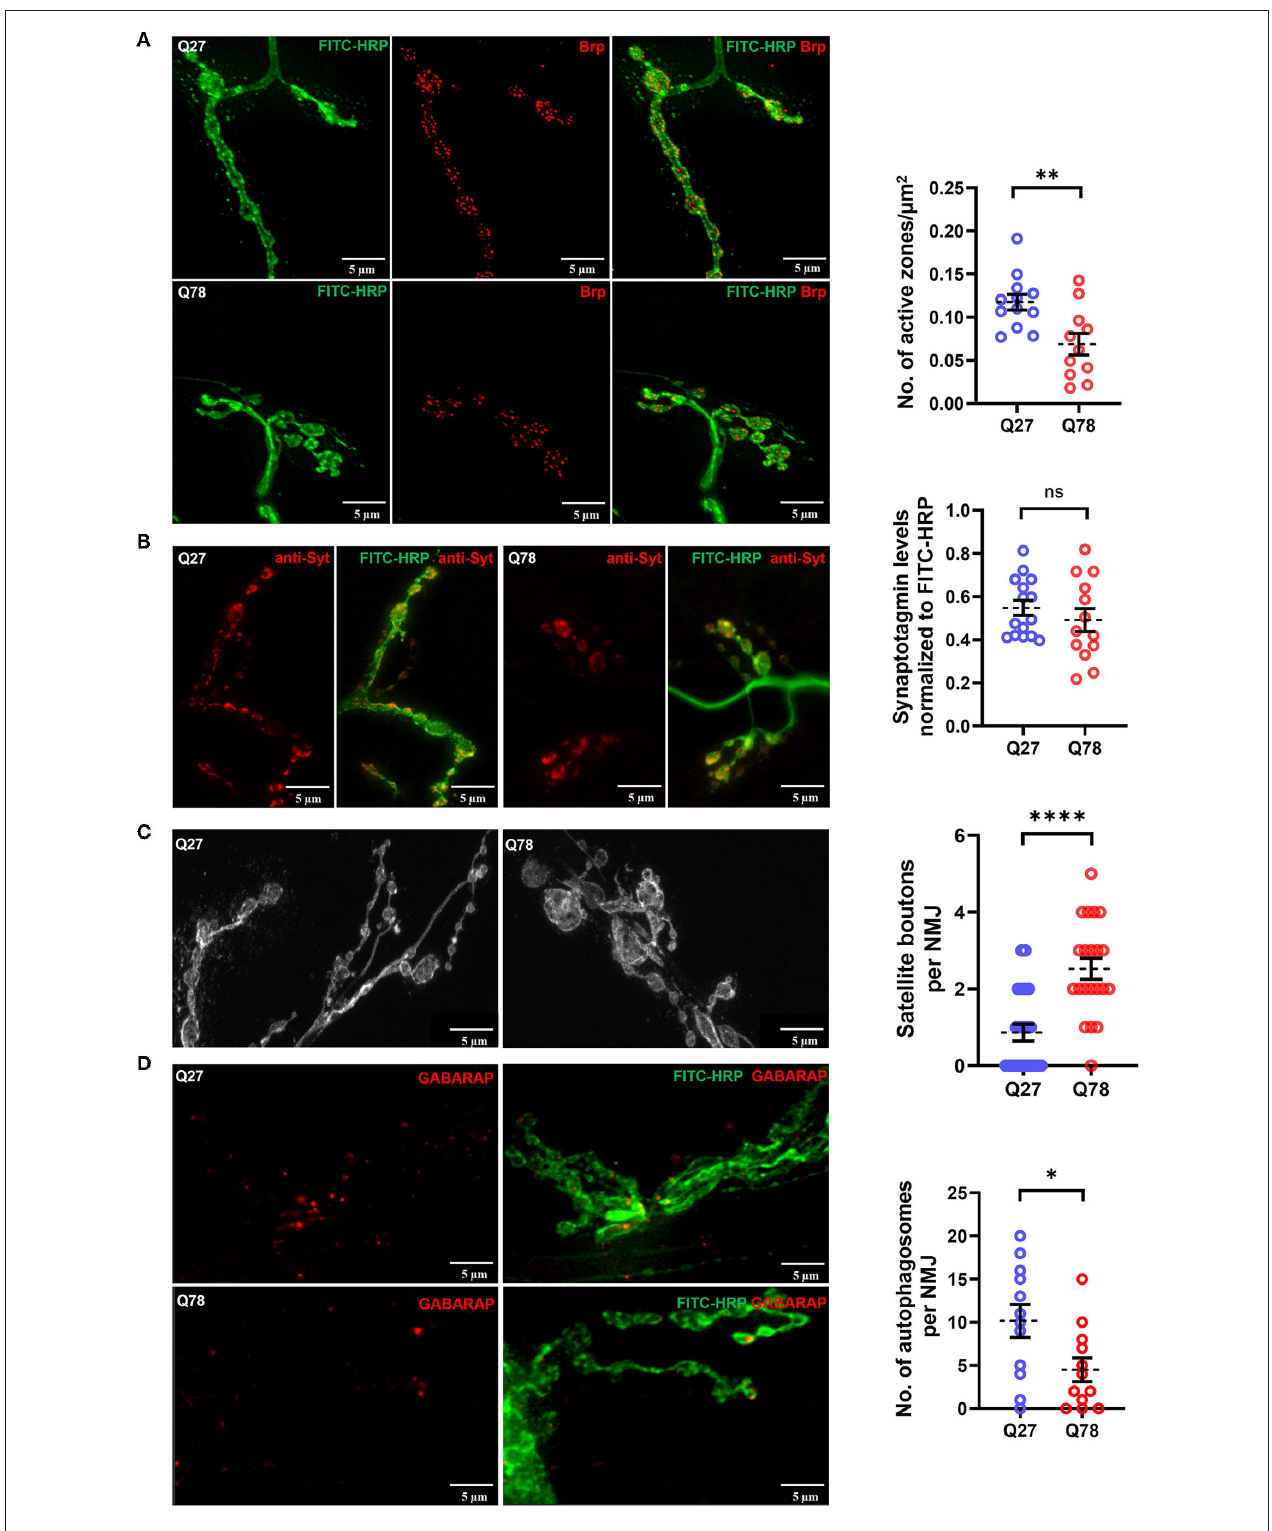
FIGURE 4 | Q78 expression in larval NMJs leads to functional changes in glutamatergic synapses. (A) A representative image of active zones marked by anti-Brp in the NMJs of the third-instar larva marked by FITC-HRP in Q27 and Q78-expressing larvae. Quantification of the number of active zones normalized to the area of NMJ. All quantifications were done on NMJs of muscle 6/7 of abdominal segments A4-A6. n ≥ 12; Student’s t -test; ** p < 0.01. An error bar represents mean ±